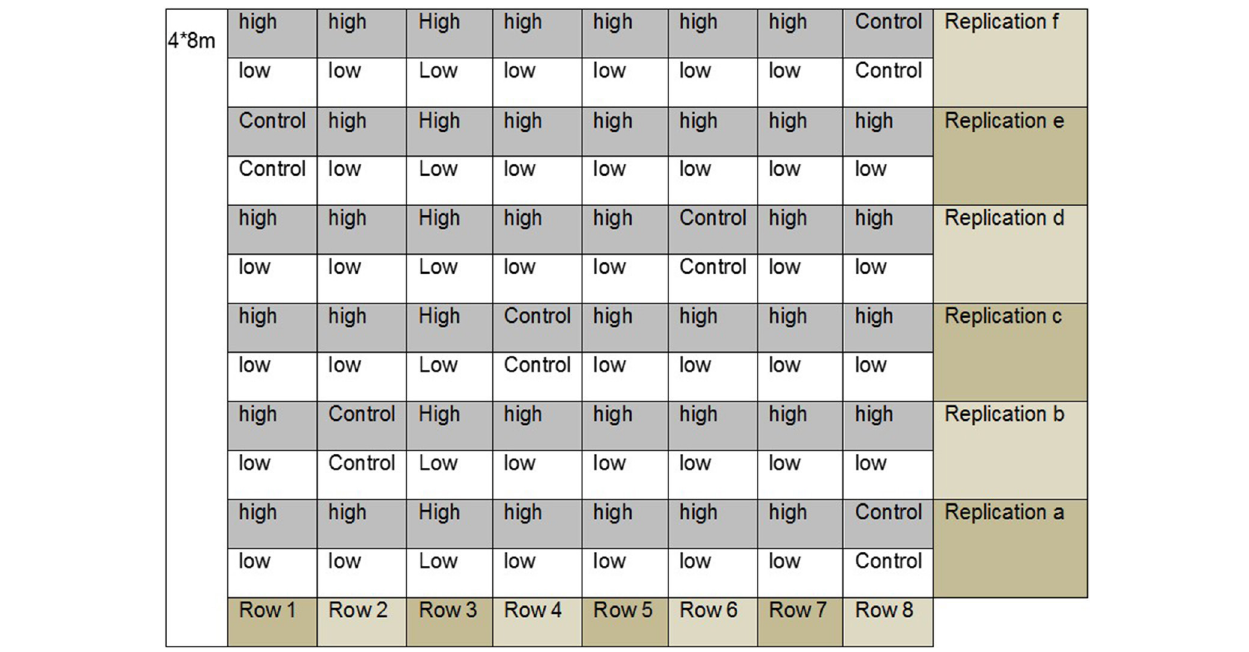
FIGURE 1 | Schematic representation of the experimental area with the distribution of the fertilized and control plots per replication.